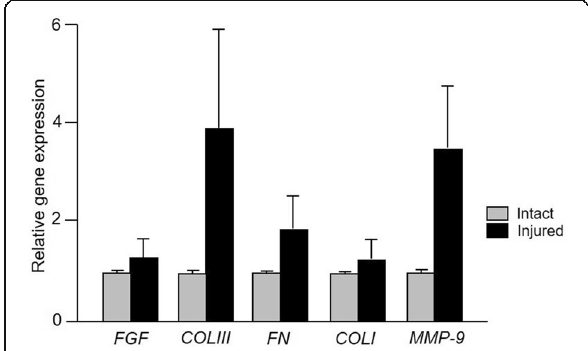
Fig. 1 Relative gene expression of Fibroblast growth factor ( FGF ), collagen III ( COL III ), fibronectin ( FN ), collagen I ( COL I ) and matrix metalloproteinase-9 ( MMP-9 ) in biopsies collected from the injured and intact area of tendon. Values reported are mean ± SEM n = 12